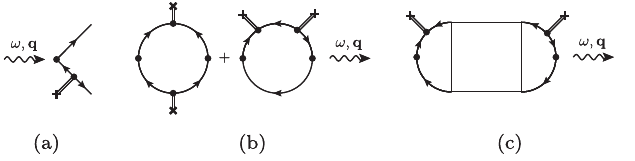
FIG. 6. (a) Elementary process where two particles with large and opposite momentum are expelled from the condensate and couple to the density probe. The continuous lines are free-particle propagators. (b) Diagrams corresponding to the free-particle high-momentum limit of the one-loop Bogoliubov diagram in Fig. 5. (c) Diagram that describes the high-momentum limit of the diagram with T -matrix insertion in Fig.